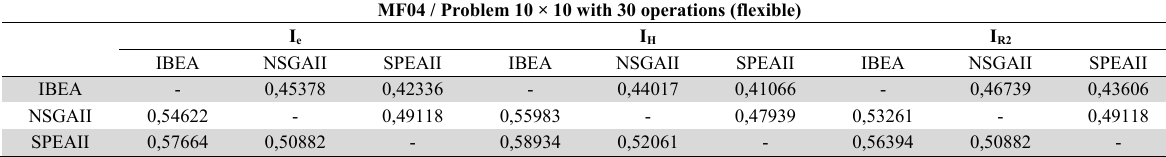
I e , I H , and I R2 (MF05) for IBEA, NSGAII and SPEAII